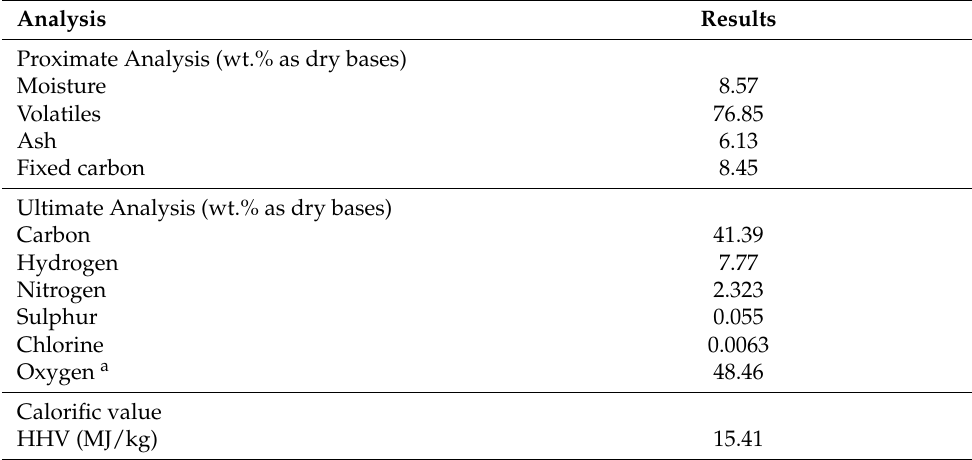
Table 1. Physicochemical characteristics of teff